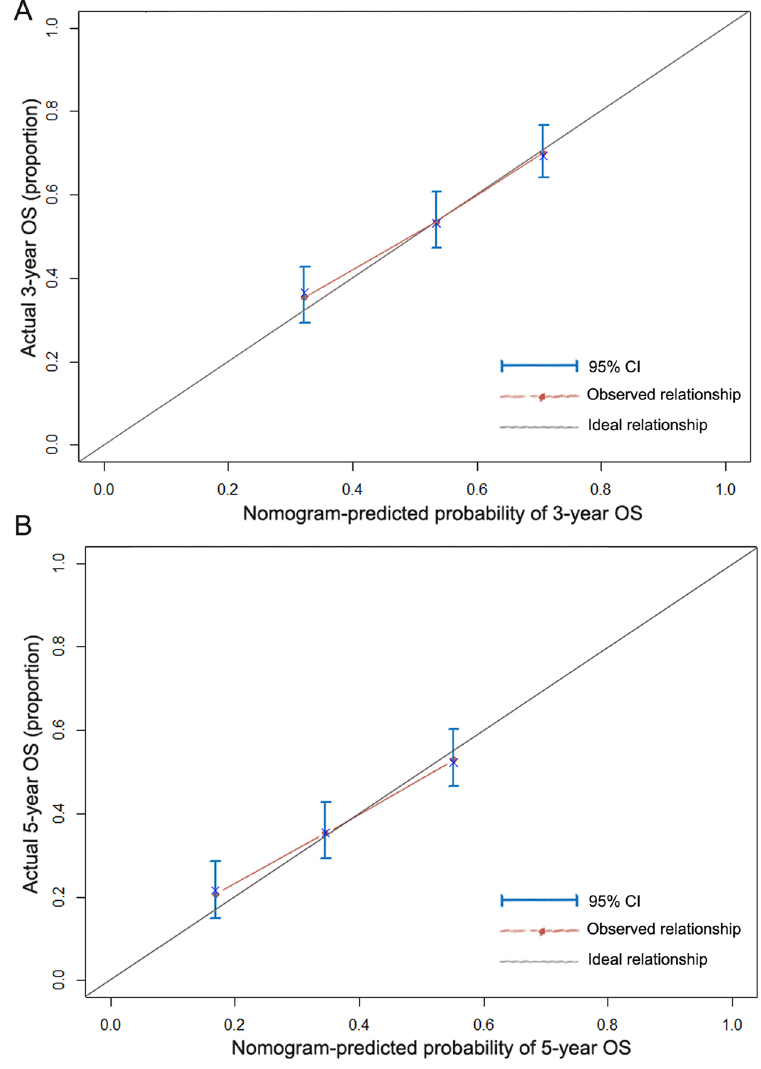
Figure 4. Calibration of nomogram-predicted 3-year overall survival (OS) ( A ) and 5-year OS ( B